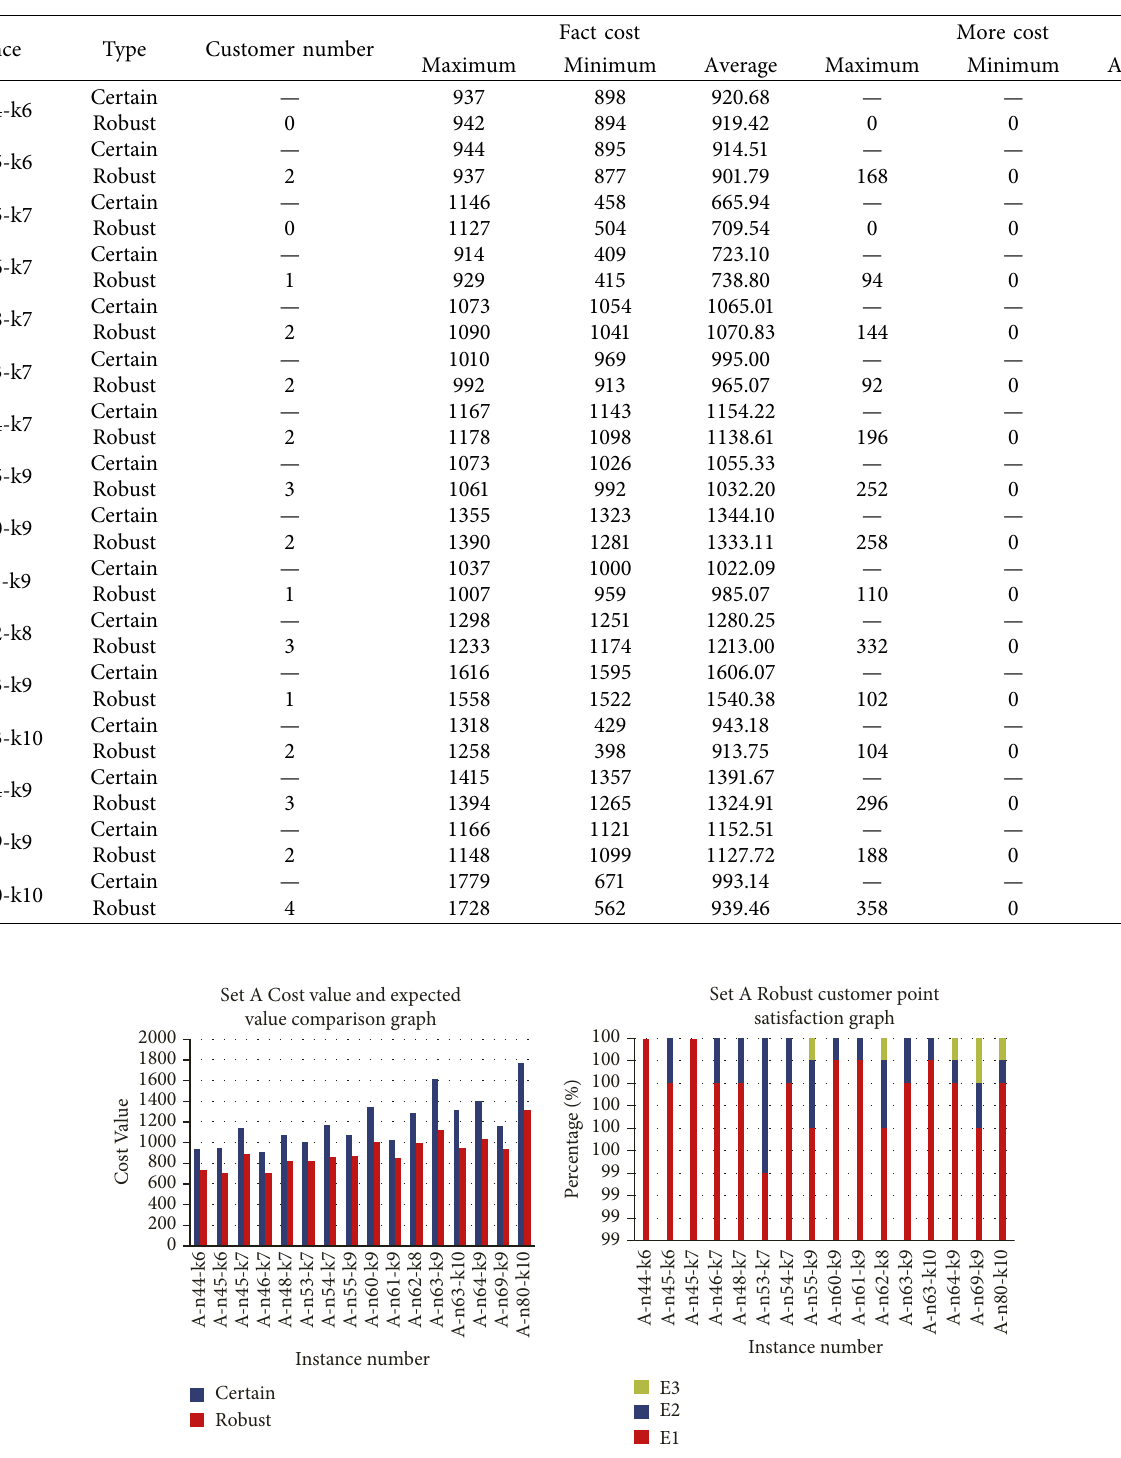
Table 4: VRPUC set A cost results.